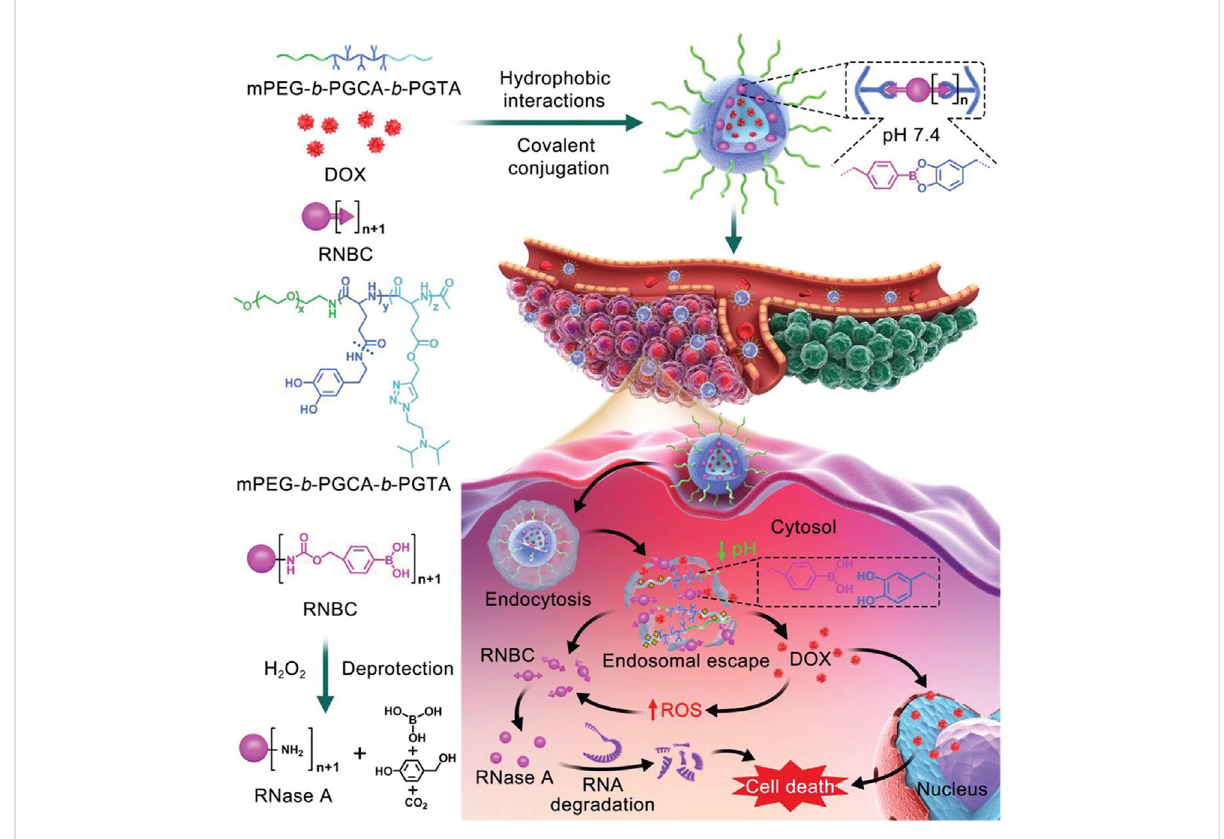
FIGURE 4 Schematic illustration of intracellular co-delivery of RNase A and Dox using a multistage cooperative drug delivery nanoplatform formed by mPEG- b -PGCA- b -PGTA for combination cancer therapy. Reproduced with permission from Ref. (Zhang et al., 2020).